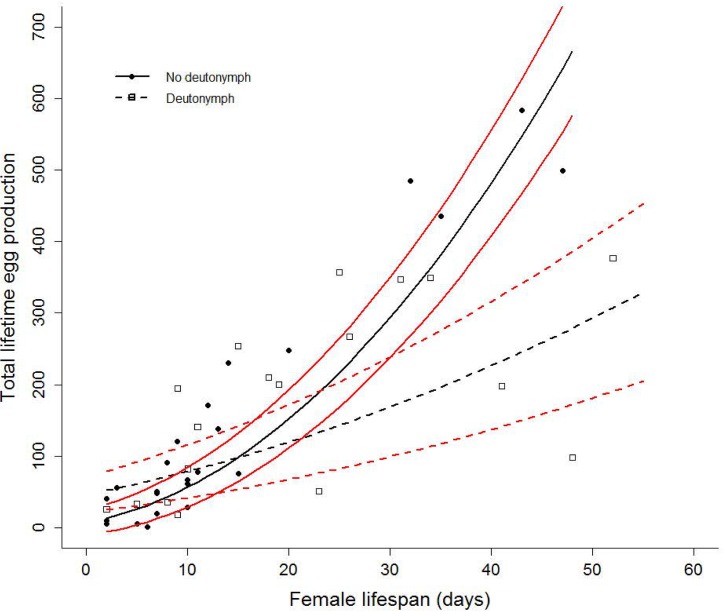
Female lifetime egg production.Lifetime egg production as a function of female lifespan for dispersers (open squares and dashed lines) and non-dispersers (solid points and solid line). Confidence intervals are shown in red; dispersers (dashed red lines), non-dispersers (solid red lines).